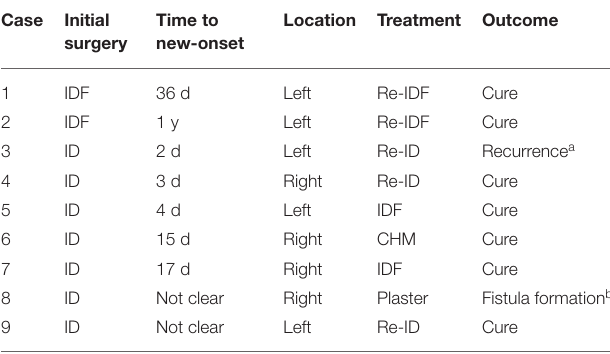
TABLE 4 | Characteristics and course of patients with new-onset abscess after initial surgery. Case Initial